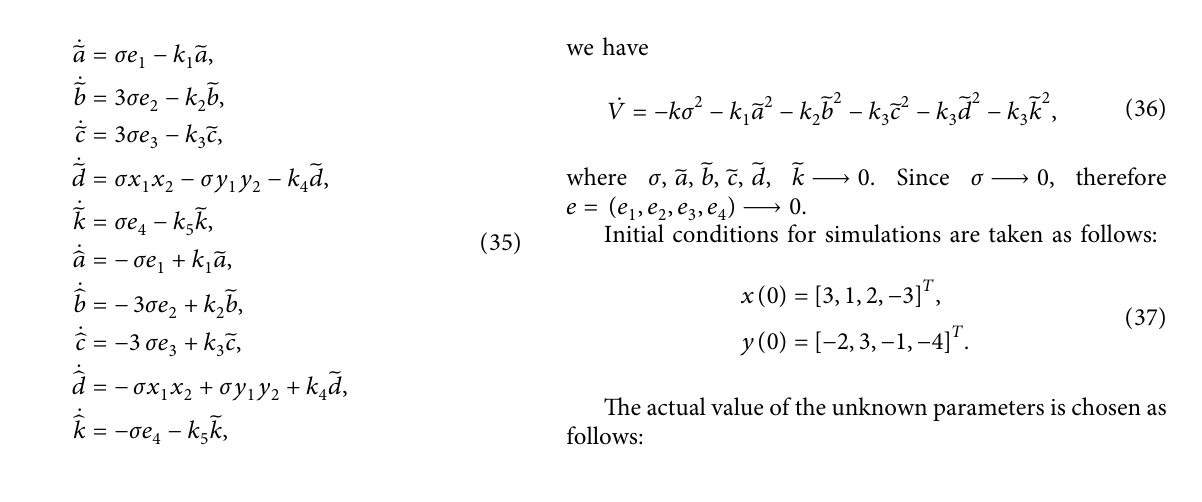
Figure 7: Synchronization of identical 4D hyperchaotic financial system with the adaptation of parameters. (a) Sliding manifold σ . (b) Control effort v